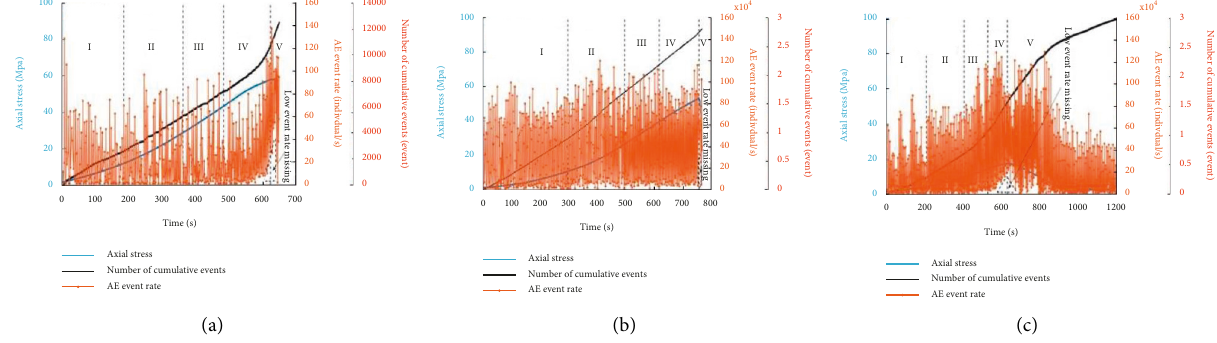
Figure 14: AE event rate, cumulative event number and stress-time curve of green sandstone. (a) 20 cycles. (b) 30 cycles. (c) 40 cycles.